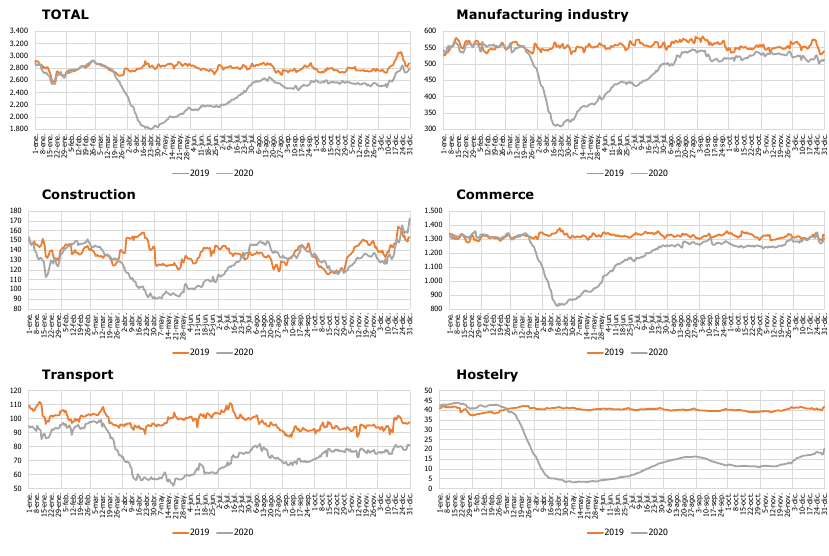
Fig. 8 Final corrected series (MA28